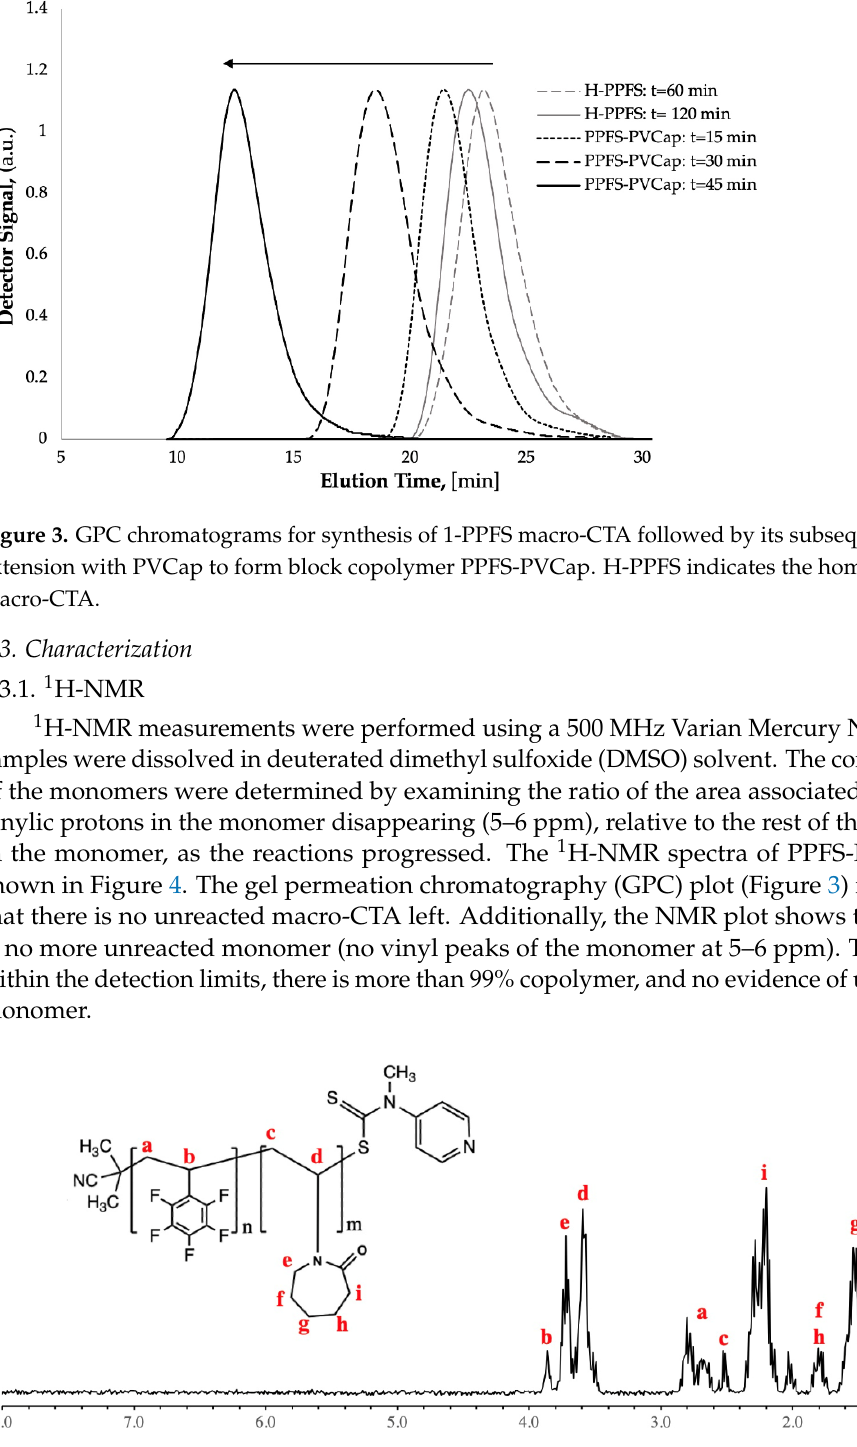
Figure 4. 1 H NMR (CDCl 3 ) of PPFS–PVCap block